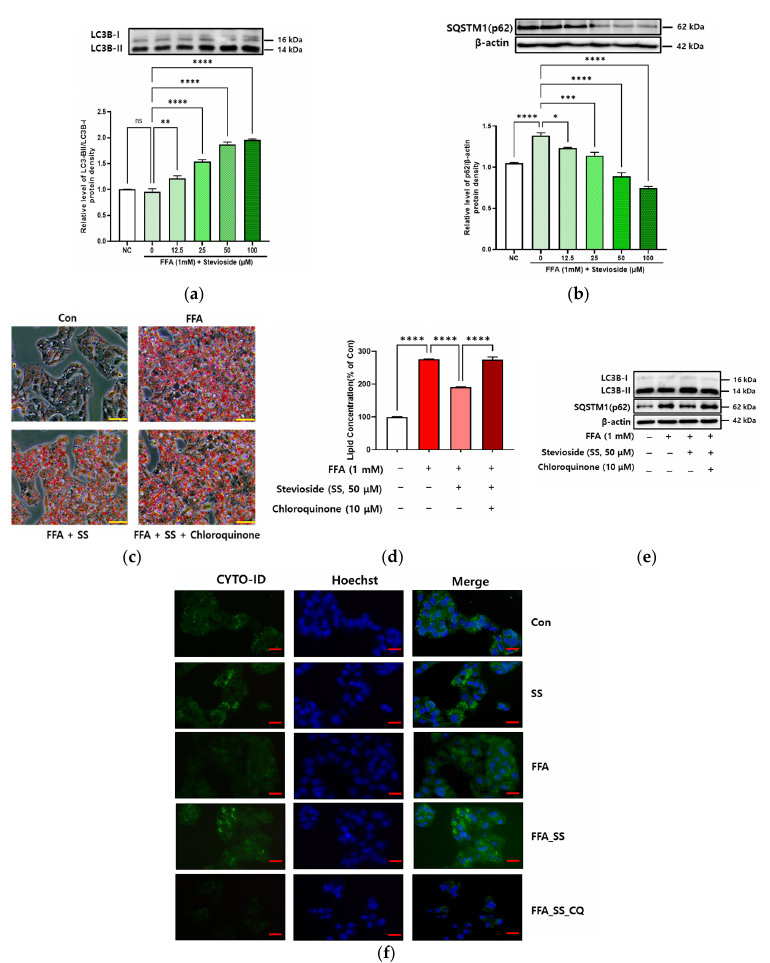
Figure 5. Stevioside induces autophagy in steatosis-induced hepatocytes. HepG2 cells were treated with 1 mM FFA and different concentrations of stevioside (SS; 0, 12.5, 25, 50, or 100 μ M) in the presence or absence of 10 μ M chloroquine (CQ) for 24 h. ( a ) Microtubule-associated protein light chain 3B (LC3B)-II/LC3B-I. ( b ) Sequestosome1 (SQSTM1). ( c ) HepG2 cells were stained with Oil Red O. Scale bar, 100 μ m. ( d ) Intracellular lipid accumulation (the absorbance of lipids was measured at 500 nm). ( e ) Immunoblot analysis. ( f ) Cells were observed by fluorescence microscopy. Scale bar, 10 μ m. All data are presented as the mean ± SE and represent results from three independent experiments. * p < 0.05, ** p < 0.01, *** p < 0.001, and **** p < 0.0001.